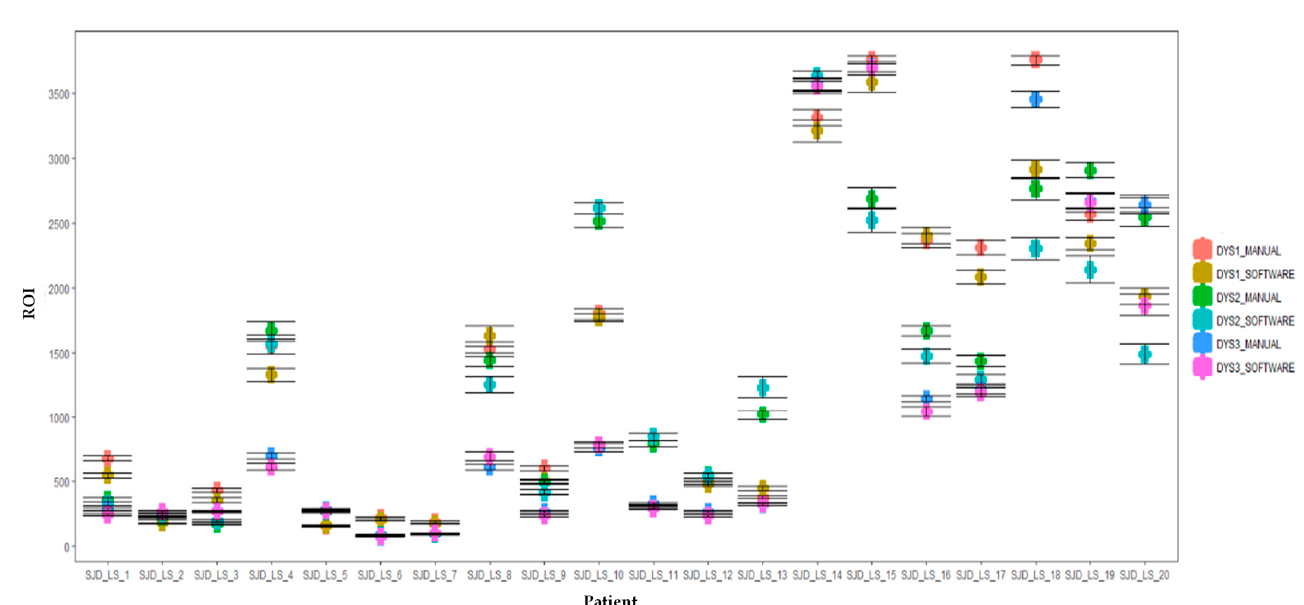
Figure 5. Boxplots of the comparison of manual and automated dystrophin quantification results. Dystrophin levels from each patient with DMD and BMD and healthy control were tested using NCL-Dys1, NCL-Dys2 and NCL-Dys3 and quantified either by a manual ROI positioning approach or with software automated approach. Results showed no significant differences. Errors bars represent standard deviation.